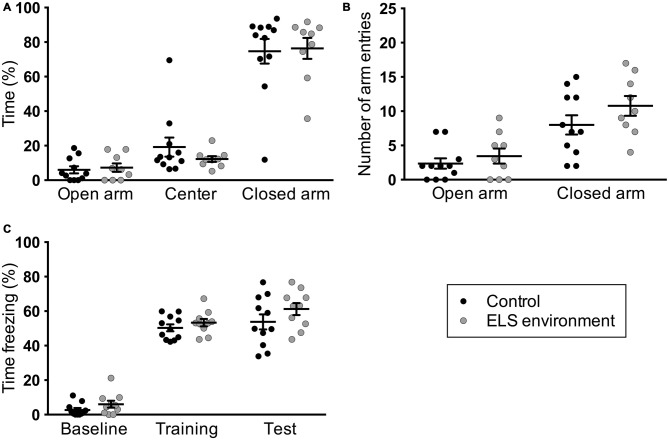
Dams in limited bedding conditions from P2–P9 do not exhibit altered anxiety-like and fear learning behaviors after pup weaning. ELS environment does not result in changes in (A) the time the dams spent in the open arms of the elevated-plus maze or (B) in the number of arm entries. (C) Contextual fear learning (“training”) or memory (“test”) was not affected as a result of limited bedding, as measured here by the amount of freezing in a specific context that is associated with foot shocks. Individual data points represent independent dams, and data are presented as mean ± SEM. n = 9–11 per group.